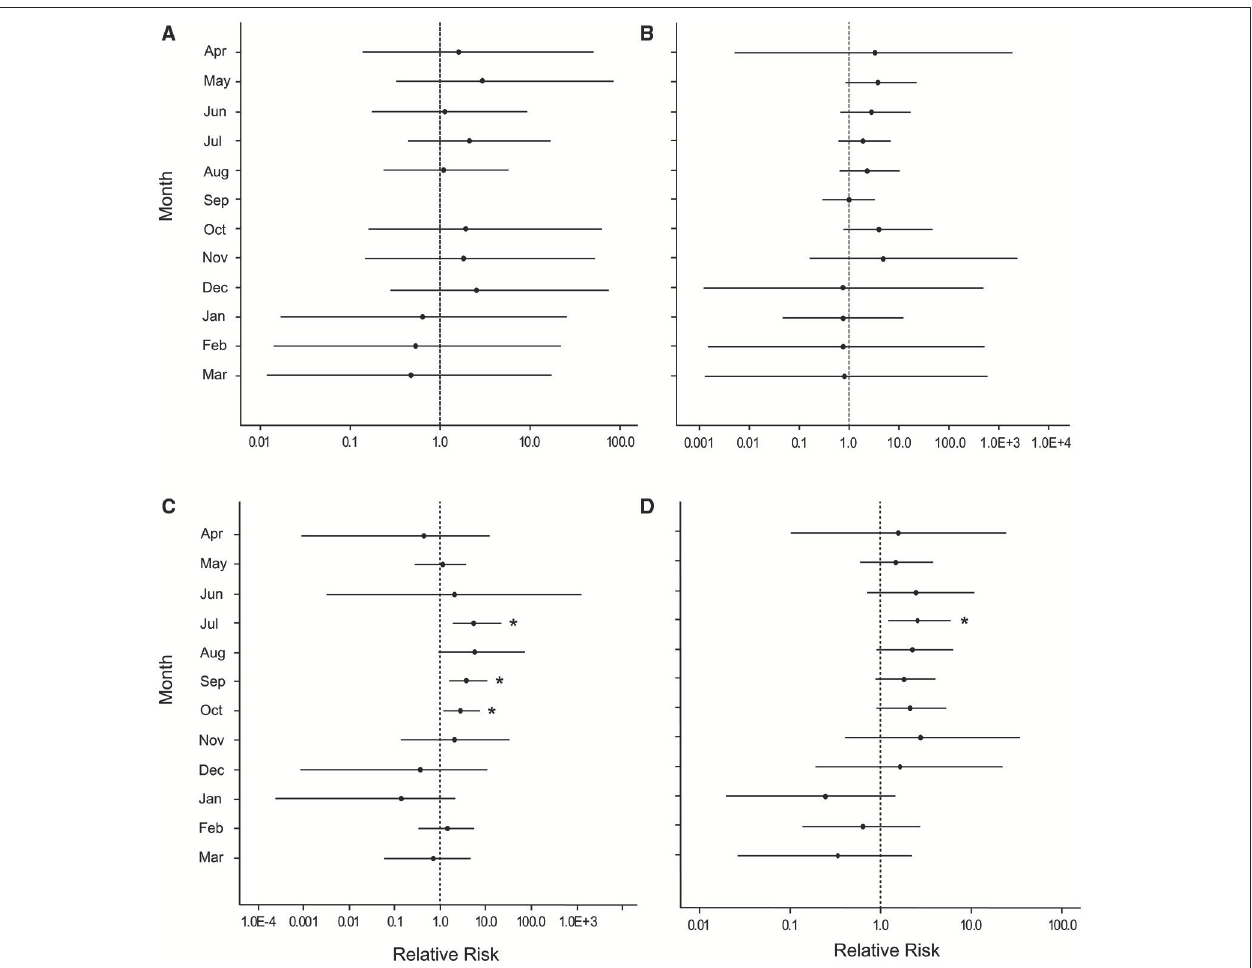
FIGURE 6 | Caterpillar plots depicting the median (black dot) and 95% credible intervals for the relative risk of white pox disease after damage from the March swells at (A) Botany Bay, (B) Hawksnest Bay, (C) Haulover Bay, and (D) all sites combined. Asterisks indicate a statistically significant increase in disease